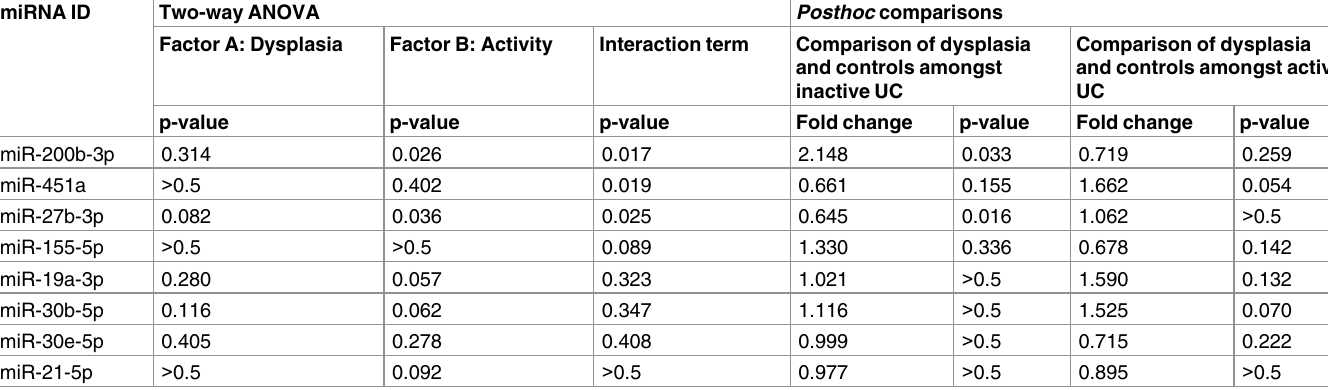
Table 3. Two-way analysis of varianceof miRNA levels in ulcerative colitis-associated dysplasia and